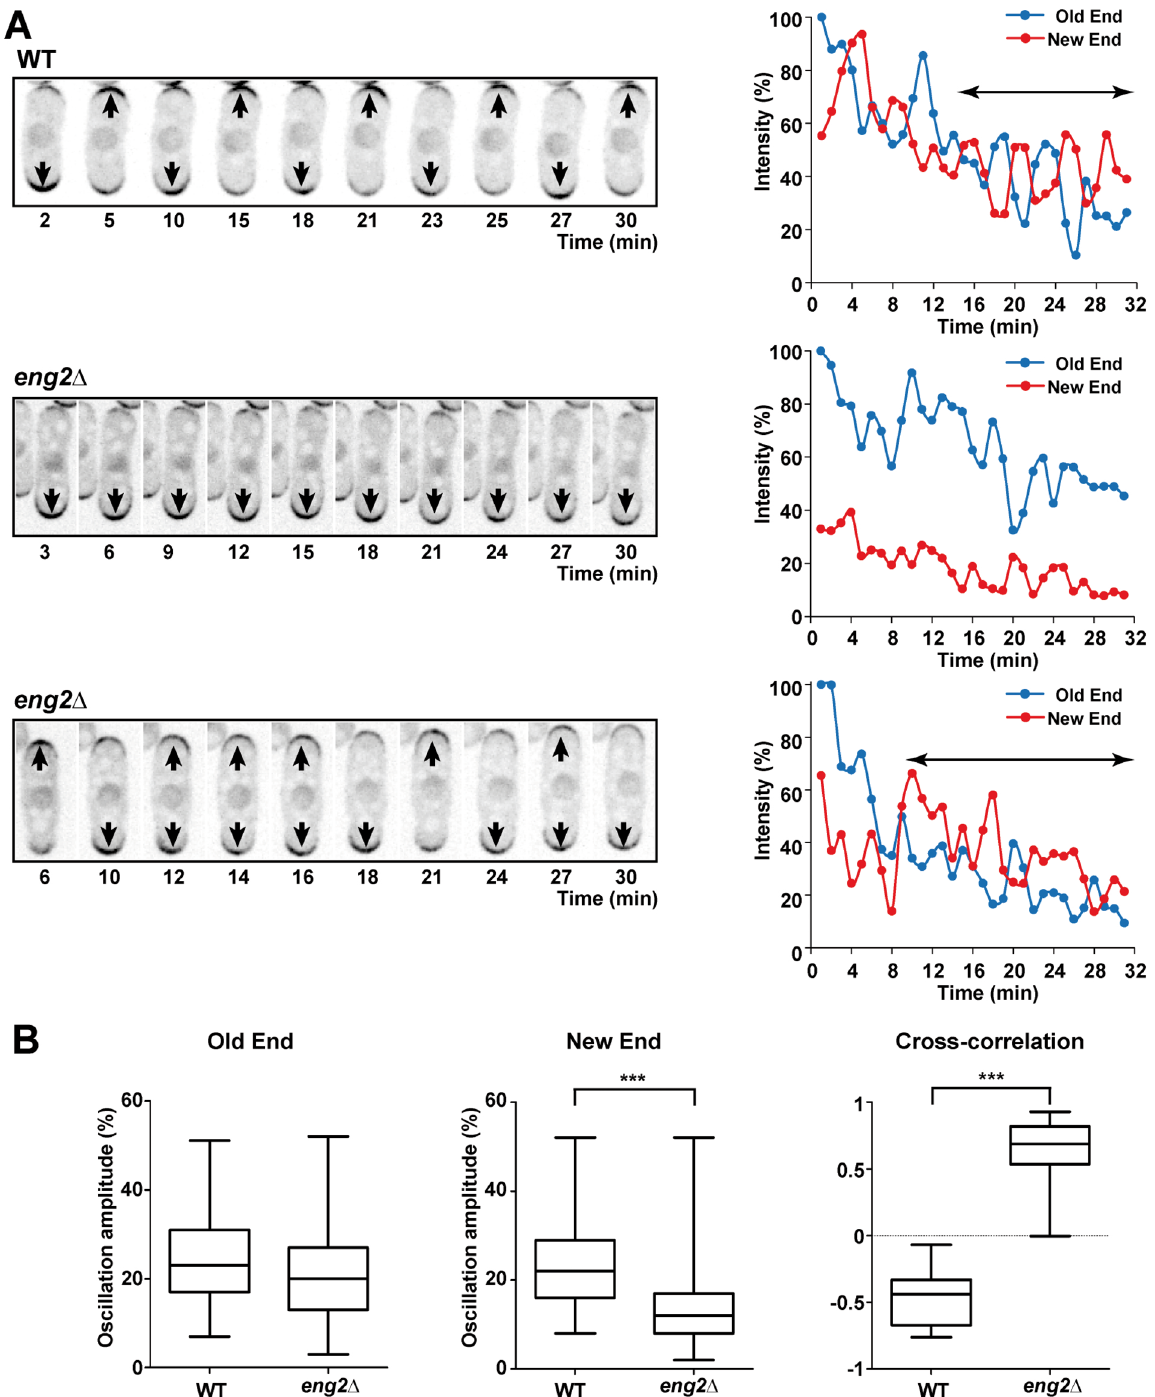
Figure 3. eng2 Δ mutants show altered oscillations of CRIB-GFP at cells tips. (A) Time lapse fluorescence micrographs of wild-type and eng2 Δ cells expressing CRIB-GFP. Microscopic analysis was performed on IBIDI chambers in YES medium at 32 °C. Images show the maximum intensity projection of 3 focal planes acquired at 0.3-µm intervals, captured at the indicated times (min). Graphs show quantification of the CRIB-GFP fluorescence intensity at the old (blue) and new (red) end in wild type and eng2 Δ cells. (B) Quantification of the oscillation amplitude (n > 100 cells) and cross-correlation (n = 15 cells) of the CRIB-GFP fluorescence signal at the old and new ends in wild type and eng2 Δ mutant. ***p-value <